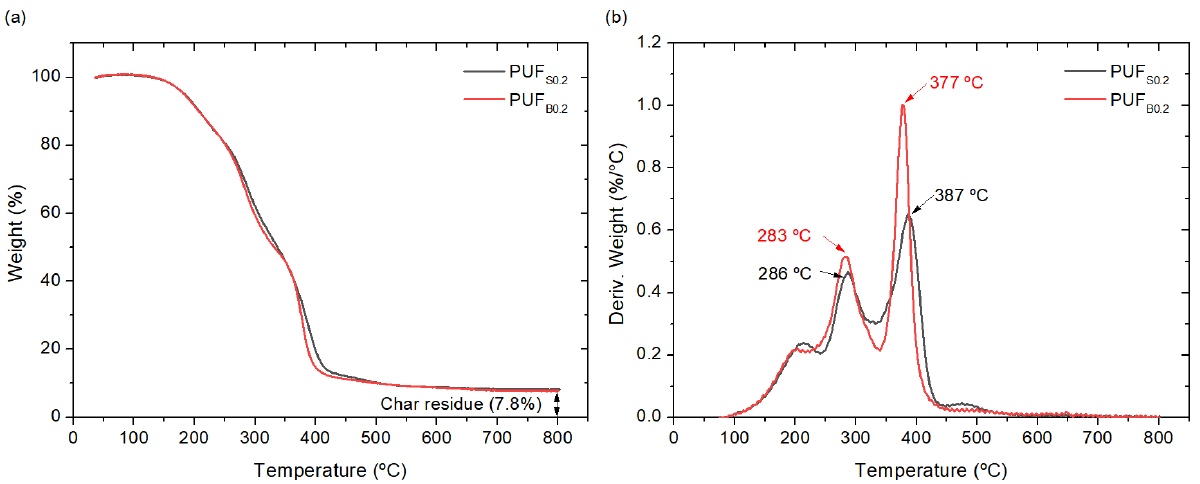
Figure 7. ( a ) TGA and ( b ) DTG curves of the PUF prepared with bismuth triflate and stannous octoate. Table 3. Parameters of the thermal stability of the prepared